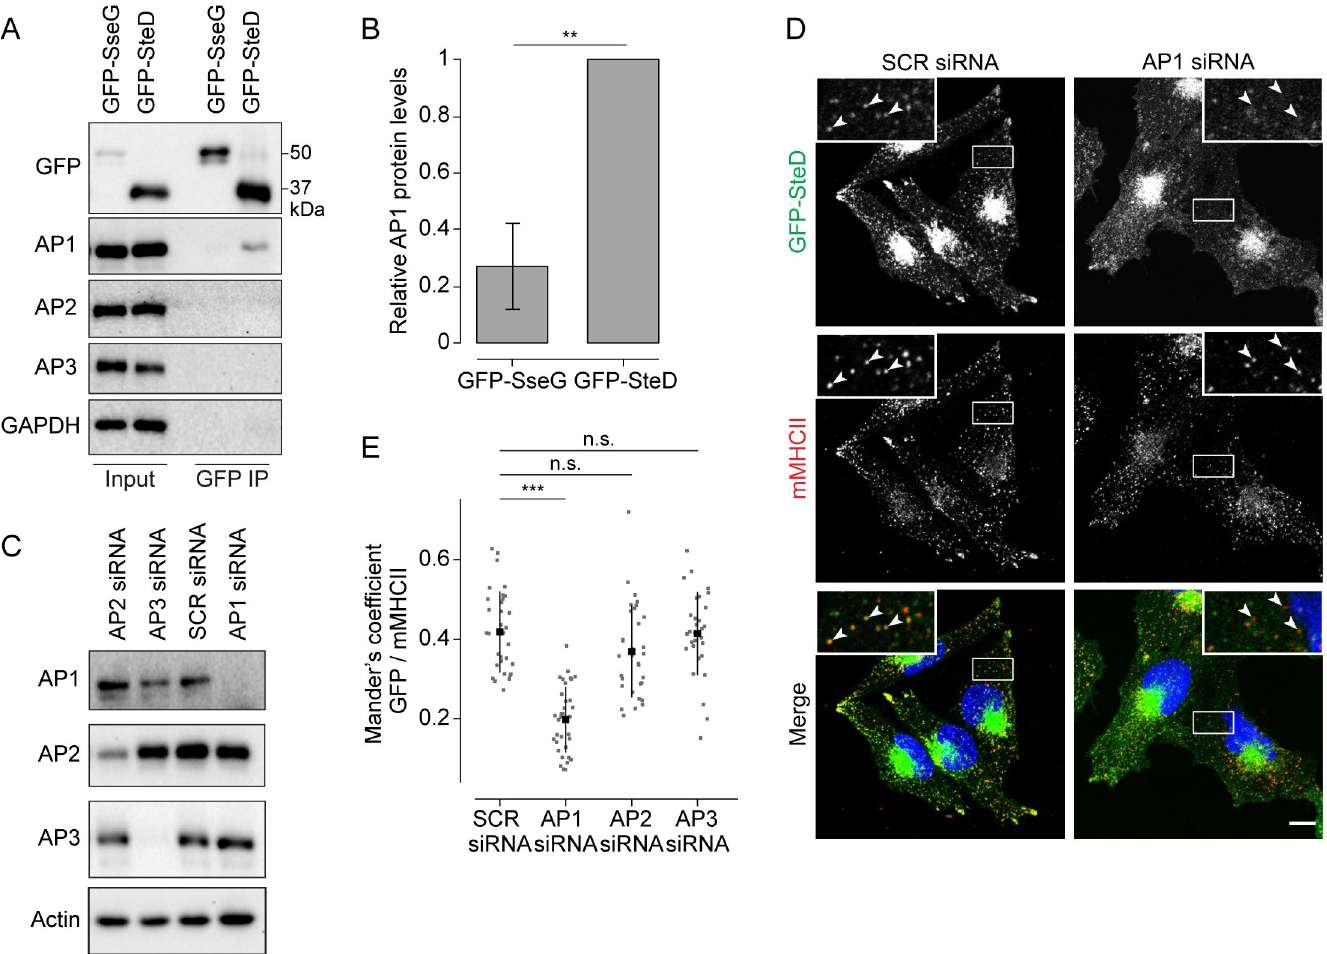
Fig 5. AP1 mediates post-TGN trafficking of SteD. (A) Protein immunoblots of whole-cell lysates (Input) and immunoprecipitation with GFP-trap beads (GFP IP) from Mel Juso cells expressing GFP-SteD or GFP-SseG following crosslinking with DSP. AP1 –antibody specific for the γ subunit, AP2 –antibody specific for the α subunit, AP3 –antibody specific for the δ subunit. (B) Levels of immunoprecipitated AP1 were calculated by densitometry from immunoblots as represented in Fig 5A. Protein levels were normalised to GFP-SteD. Mean of three independent experiments ± SD. The data were analysed by one sample t-test, �� p < 0.01. (C) Protein immunoblots of Mel JuSo cells treated with scrambled siRNA (SCR) or siRNA specific to the β subunit of AP1, the μ subunit of AP2 or the δ subunit of AP3. AP1 – antibody specific for the β subunit, AP2 –antibody specific for the α subunit AP3 –antibody specific for the δ subunit. (D) Representative confocal immunofluorescence microscopy images of Mel JuSo cells expressing GFP-SteD after treatment with scrambled siRNA (SCR) or siRNA specific to the β subunit of AP1. Cells were fixed and processed for immunofluorescence microscopy by labelling for MHCII compartments (mMHCII, red), and DNA (DAPI, blue). Arrowheads indicate MHCII compartments. Scale bar– 10 μ m. (E) Mander’s overlap coefficient of the fraction of GFP-SteD positive pixels that colocalise with mMHCII positive pixels from cells after treatment with siRNA as in Fig 5C and 5D. Data are representative of three independent experiments. Each dot represents the value for one cell. Mean ± SD. Data were analysed by one-way ANOVA followed by Dunnett’s multiple comparison test, ��� p < 0.001, n.s.–not significant.